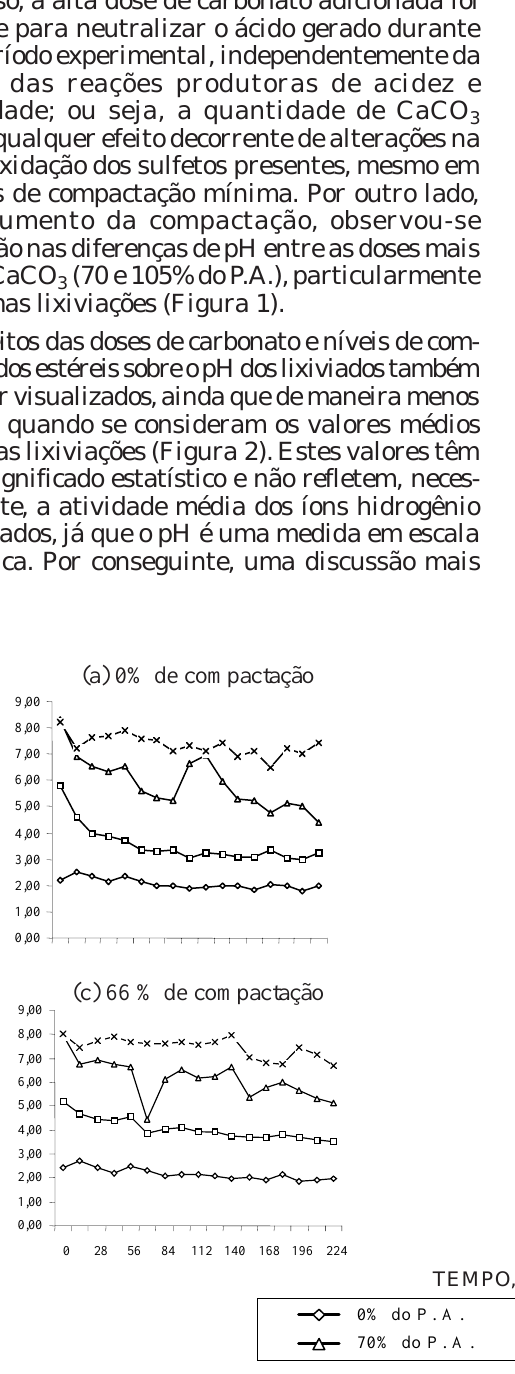
Figura 1. Valores de pH nos lixiviados, considerando o tempo, para diferentes doses de carbonato e níveis de